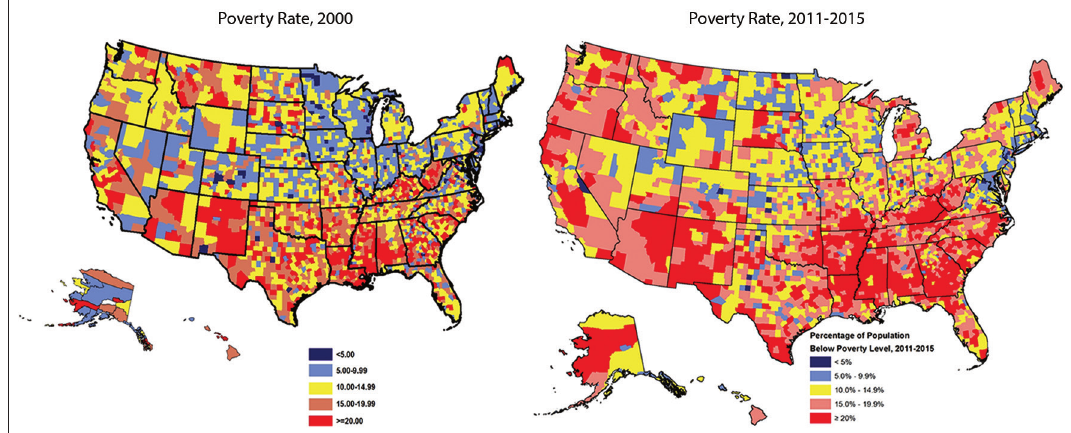
Figure 3. Percentage of Population Below the Federal Poverty Level, United States, 2000 and 2011-2015 (3,143 Counties) Source: Data derived from the 2000 Census and 2011-2015 American Community Survey.